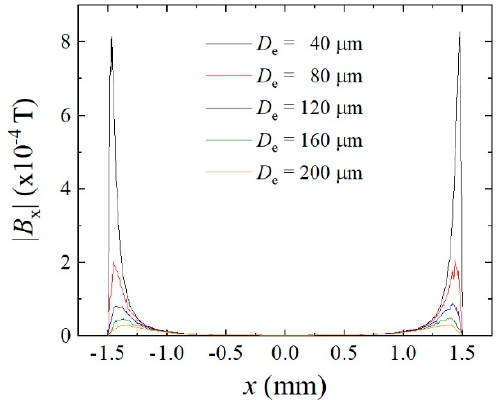
Figure 17. Vector diagram of the magnetic flux density arising from one narrow strip element.